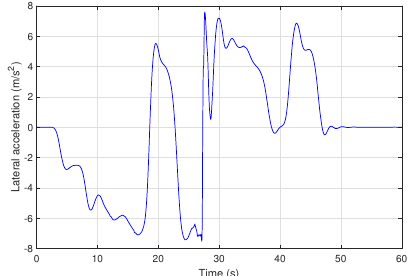
Figure 13. Lateral acceleration of the